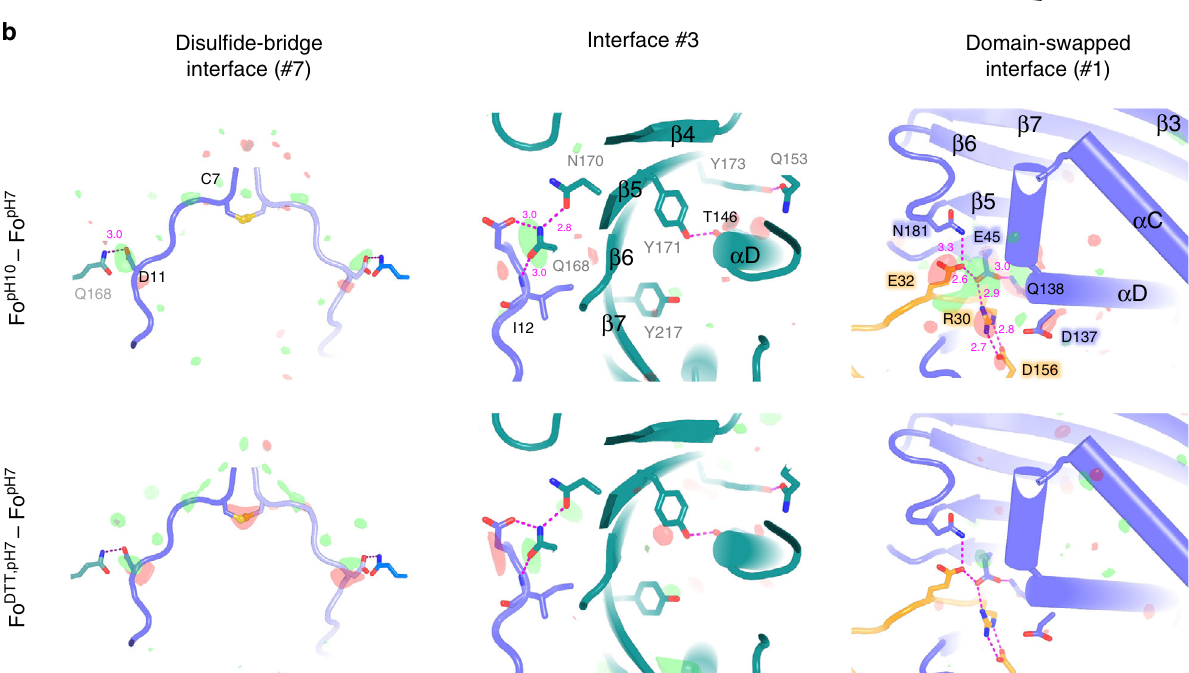
Fig. 2 Disul fi de-bridge chaining of domain-swapped (DS) dimers in the natural Cyt1Aa crystals. a Cyt1Aa dimers associated through a DS interface constitute the building block of natural crystals. These DS dimers are chained one to another by a disul fi de bridge at position C7. b Fourier difference maps computed between datasets, and phased by the pH7 structure, highlight the most striking conformational changes upon pH elevation (upper panels; Fo [pH10] – Fo [pH7] map) and DTT soak (lower panels; Fo [DTT] – Fo [pH7] map). The difference maps are overlaid on the pH7 protoxin structure, shown as a slate-colored ribbon. Symmetry related molecules are all colored differently, with each molecule having the same color coding in all panels. From left to right, the fi gure shows the maps contoured at ±3 σ around the disul fi de bridge, at crystal packing interface #3 and at the DS interface, respectively. Positive and negative peaks are shown in green and red. Secondary structure information is overlaid on the